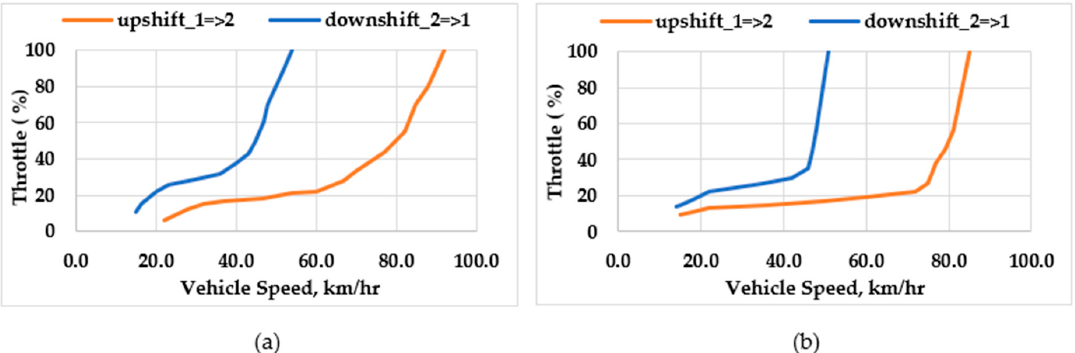
Figure 17. Conventional rule-based (i.e., throttle or torque demand and vehicle speed) gearshift strategy: ( a ) gearshift strategy—01 [11] and ( b ) gearshift strategy—02 [8].